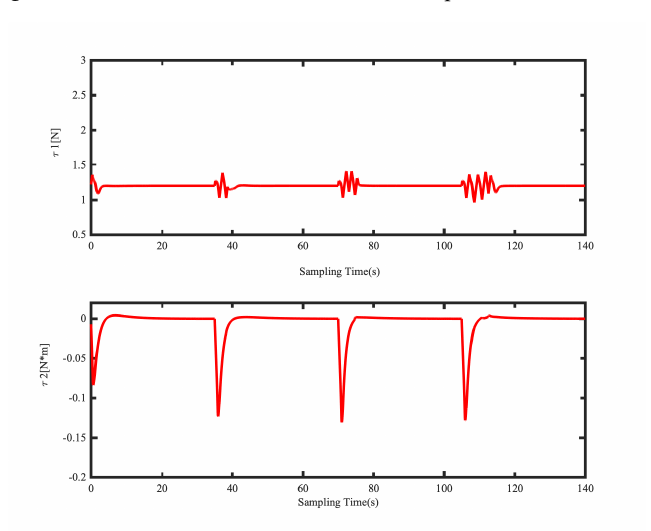
Figure 11. Control input signals-Case